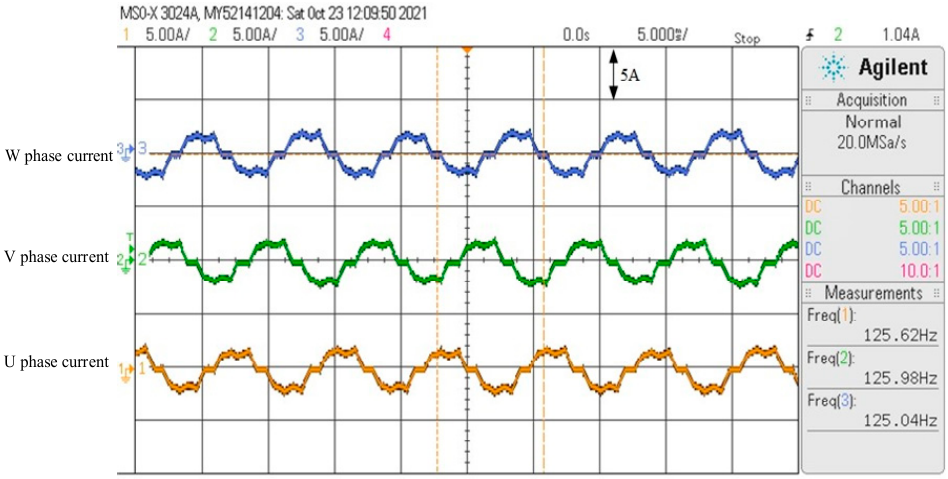
Figure 23. 3-phase output current waveform of the commercially available drive at rotational speed frequency command of 150 Hz.